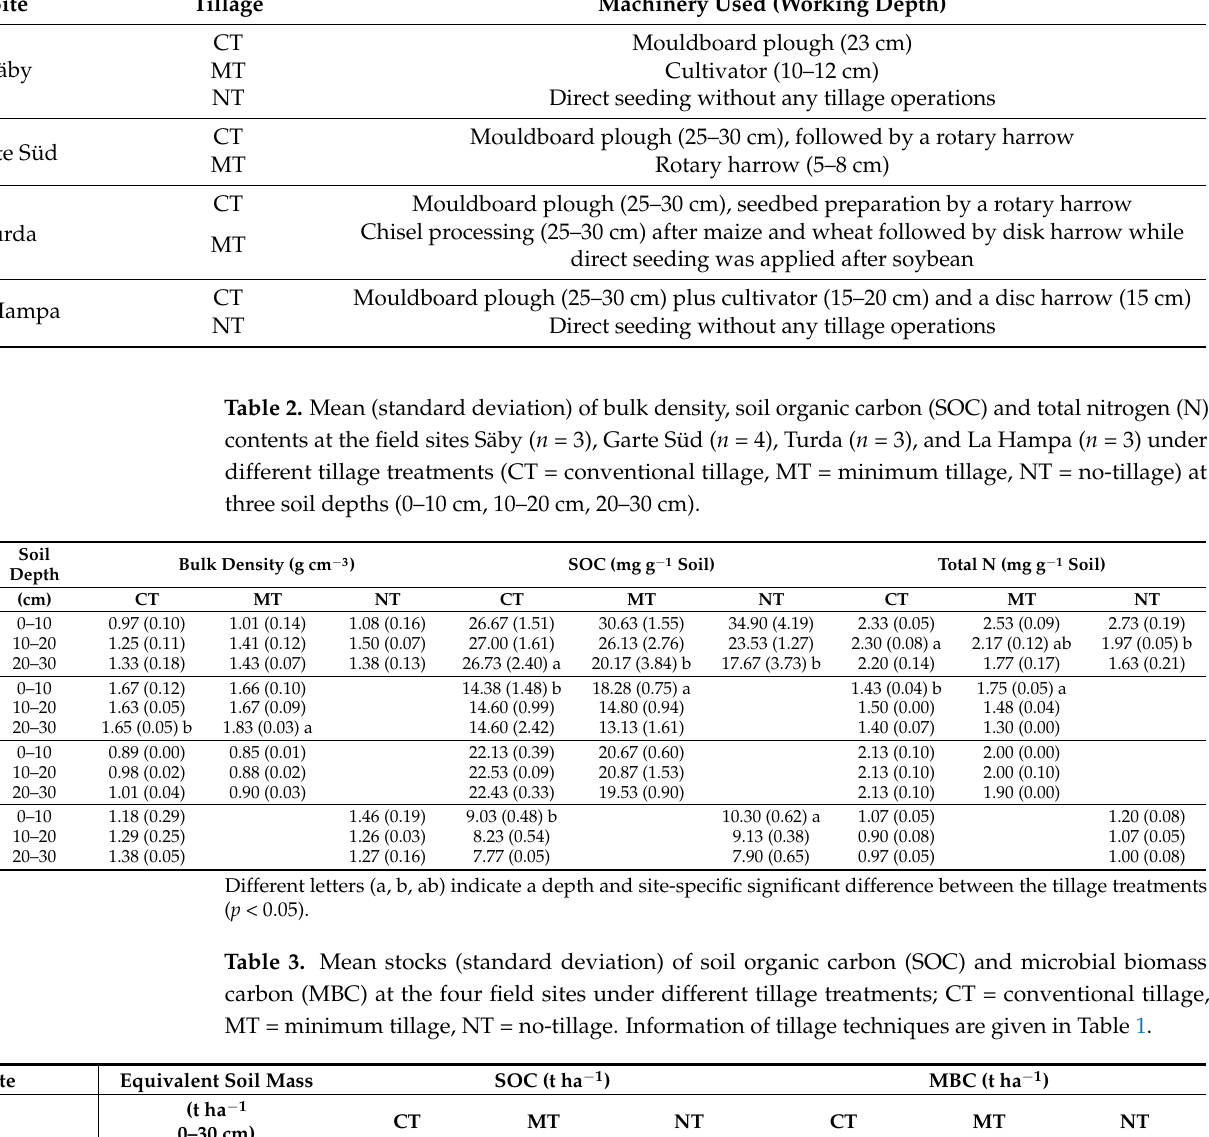
Table 1. Overview of the different tillage treatments at the four field sites; CT = conventional tillage, MT = minimum tillage, NT = no-tillage.